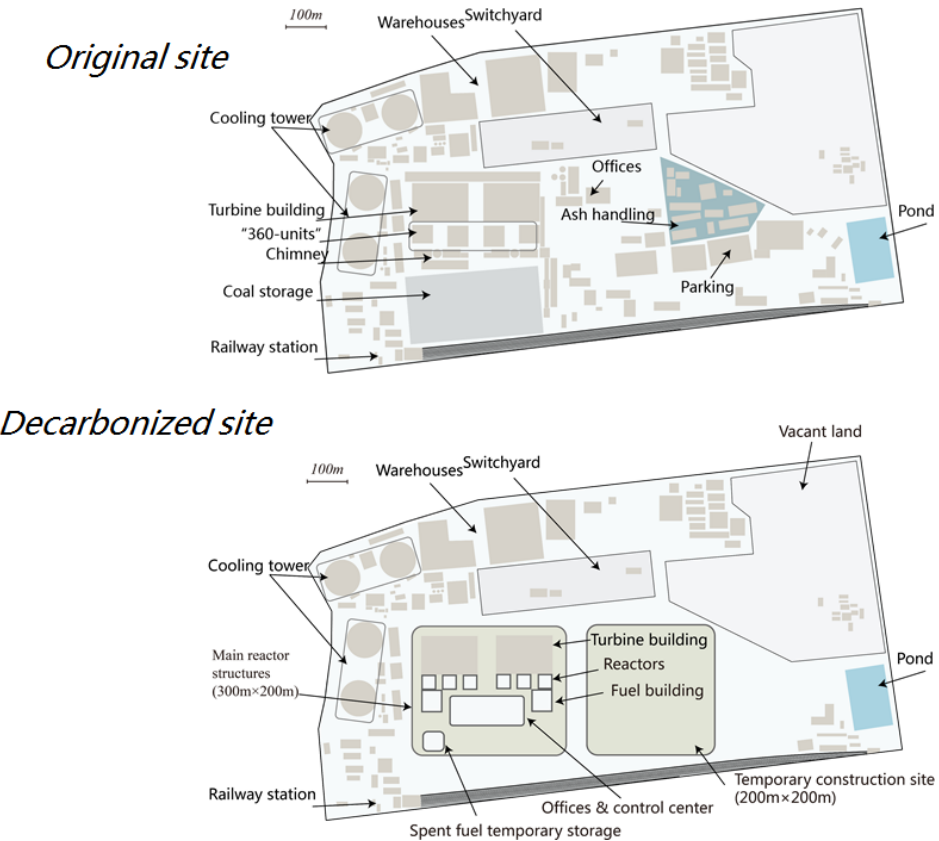
Figure A7. Retrofit decarbonization of Taishan with nuclear reactors.